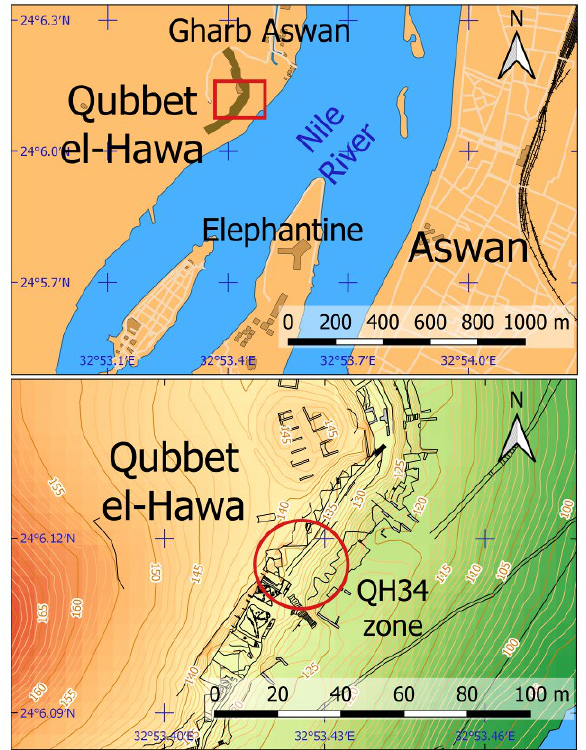
Figure 1. Location of the necropolis of Qubbet el-Hawa (Aswan, Egypt) and the QH34